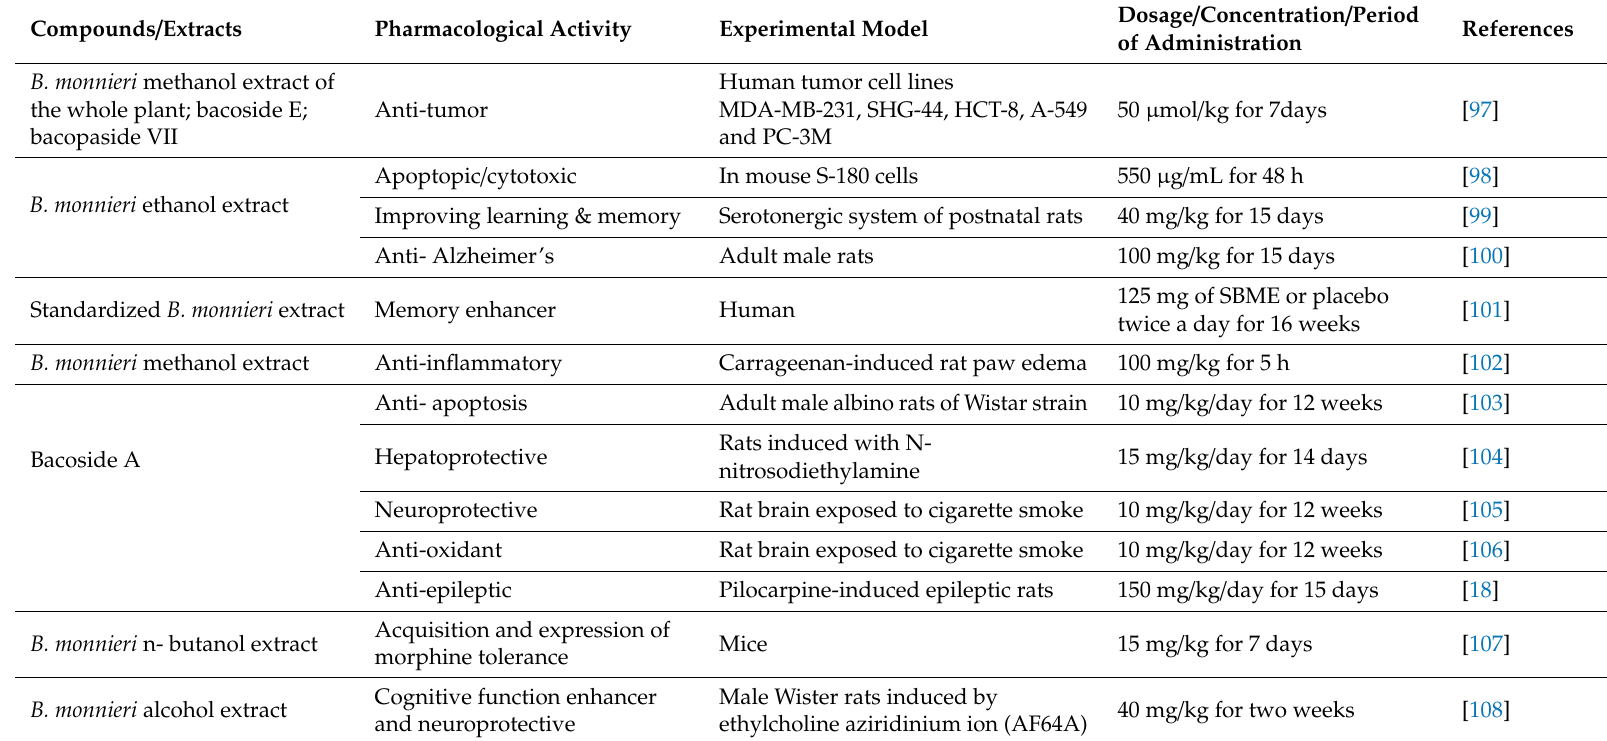
Table 3. Pharmacological activities of B. monnieri (L.) and its active